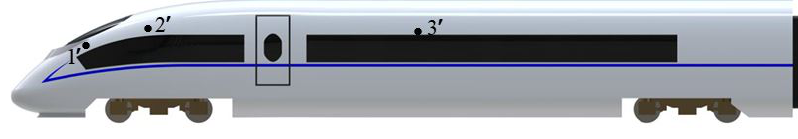
Fig. 6. Validation model and monitoring points in reference [11] Table 2. Comparison of numerical simulation and real vehicle test